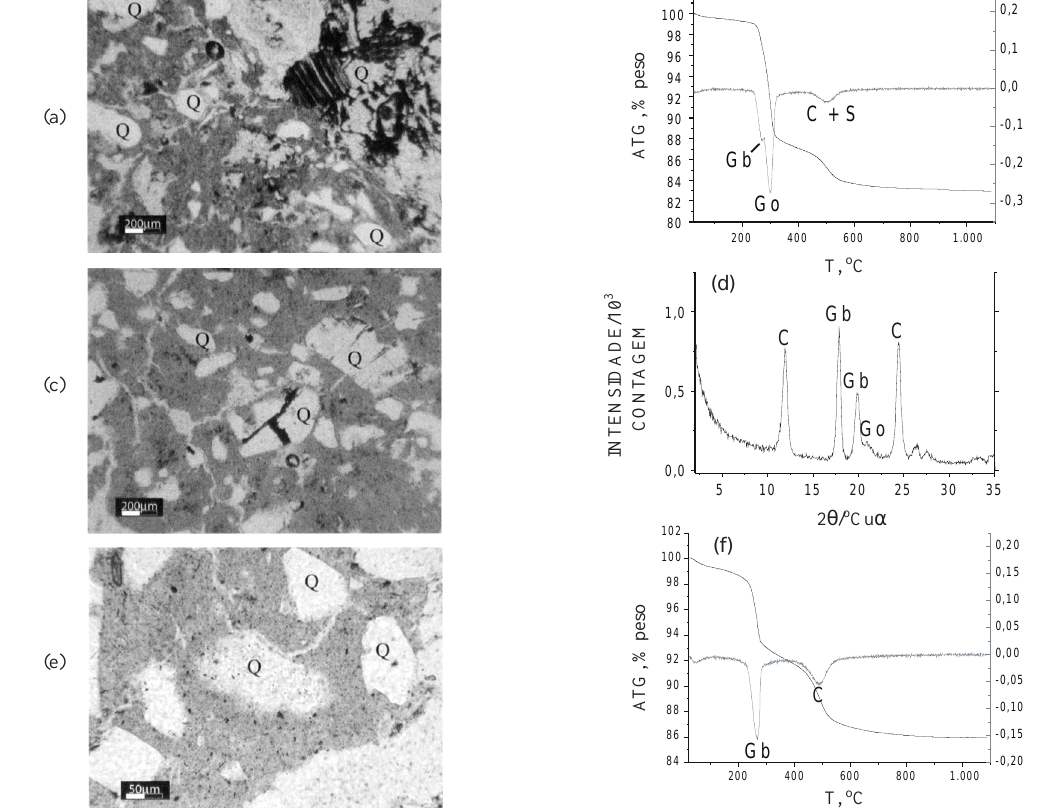
Figura 5. Aspectos micromorfológicos e mineralógicos da toposseqüência 2. (a) = Fotomicrografia em luz plana do horizonte C de VH2. (b) = ATG e sua derivada, mostrando a composição do plasma incipiente do horizonte C de VH2. (c) = Fotomicrografia em luz plana do horizonte B de VH3, mostrando o esqueleto quartzoso (Q) com ferruginização em contato abrupto com o plasma. (d) = DRX do horizonte B de VH3. (e) = Fotomicrografia em luz polarizada do horizonte B de VH4, (Q) = esqueleto quartzoso. (f) = ATG e sua derivada do horizonte B de Vh4. C = caulinita, Gb = gibbsita, Go = goethita, S =